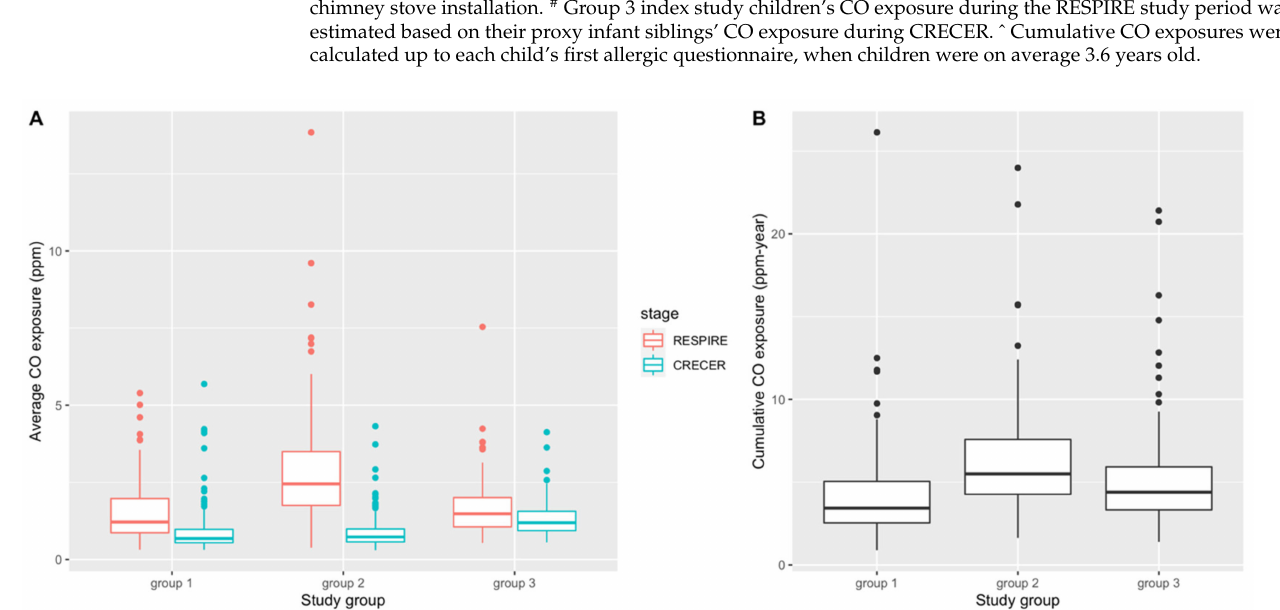
Figure 2. Distribution of average CO exposure levels (ppm) ( A ) and cumulative CO exposure (ppm-year) ( B ) during RESPIRE and CRECER study stages before first allergy questionnaire. Group 1 = <6 months; Group 2 = ~18 months and Group 3 = ~57